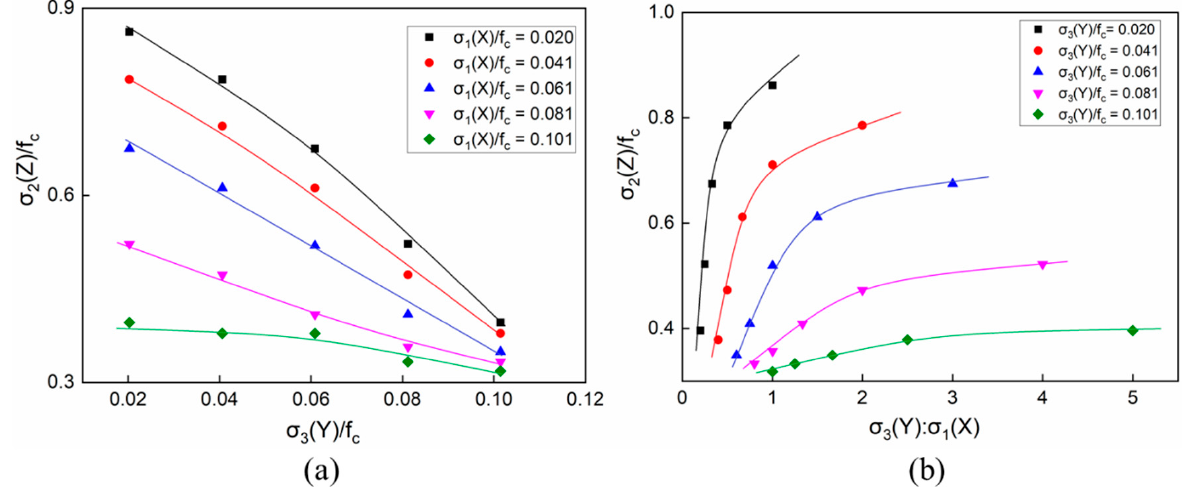
Figure 16. The compressive strength of the concrete under a compressive–tensile–tensile condition: ( a ) σ 3 / f c along the horizontal axis and ( b ) σ 3 / σ 1 along the horizontal axis.